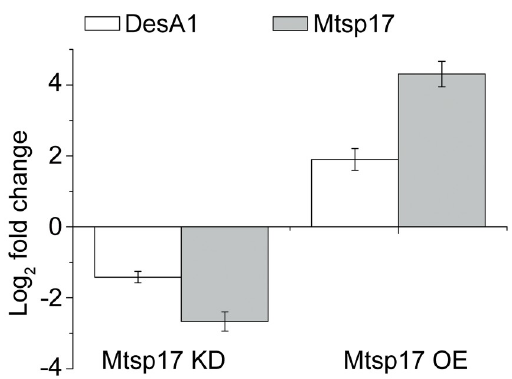
Fig 3. Fold changes of DesA1 and Mtsp17 mRNA. Mtsp17 KD, a conditional Mtsp17 knockout strain, incubated in the absence of the inducer tetracycline for 4 additional hours. Mtsp17 OE, the Mtsp17 over-expression strain. https://doi.org/10.1371/journal.pone.0249379.g003 Mtsp17 activating desA1 (Table 3). The above results indicate that Mtsp17 is likely a transcrip- tional activator of the desA1 gene.